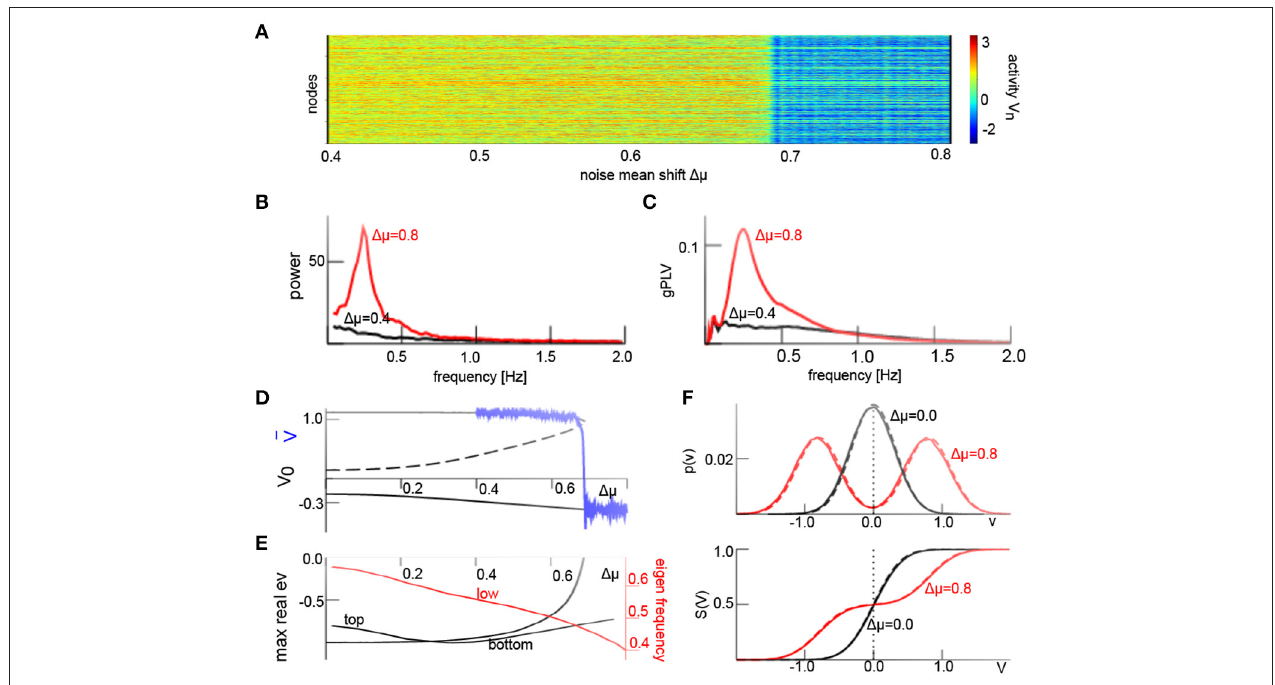
FIGURE 6 | Additive non-iid noise induces phase coherent oscillations. (A) Spatio-temporal activity V ( t ) and jump from non-oscillatory high-activity to oscillatory low-activity state for increasing noise mean shift 1µ in the interval 1µ [0.4 0.8] over 200 s . (B) Power spectral density of spatial mean ¯ V ( t ) computed in a time ∈ ; window of 800s. (C) Global phase coherence gPLV in a time window of 400s. (D) Equilibria ¯ V 0 (black) and simulated spatial average ¯ V ( t ), solid (dashed) lines denote stable (unstable) states. (E) Maximum Lyapunov exponents of respective stable equilibria (black) and eigenfrequency of the bottom state (red). (F) probability density function p ( υ ) (8) and resulting transfer functions (24) from analysis (solid line) and numerical solution (dashed line). D 1 0.1 and other parameters are taken from = Figure 4 ; results for W n ( t ) are equivalent. We have applied the Euler-Maryuama integration technique [ 41] with time step 1 t =